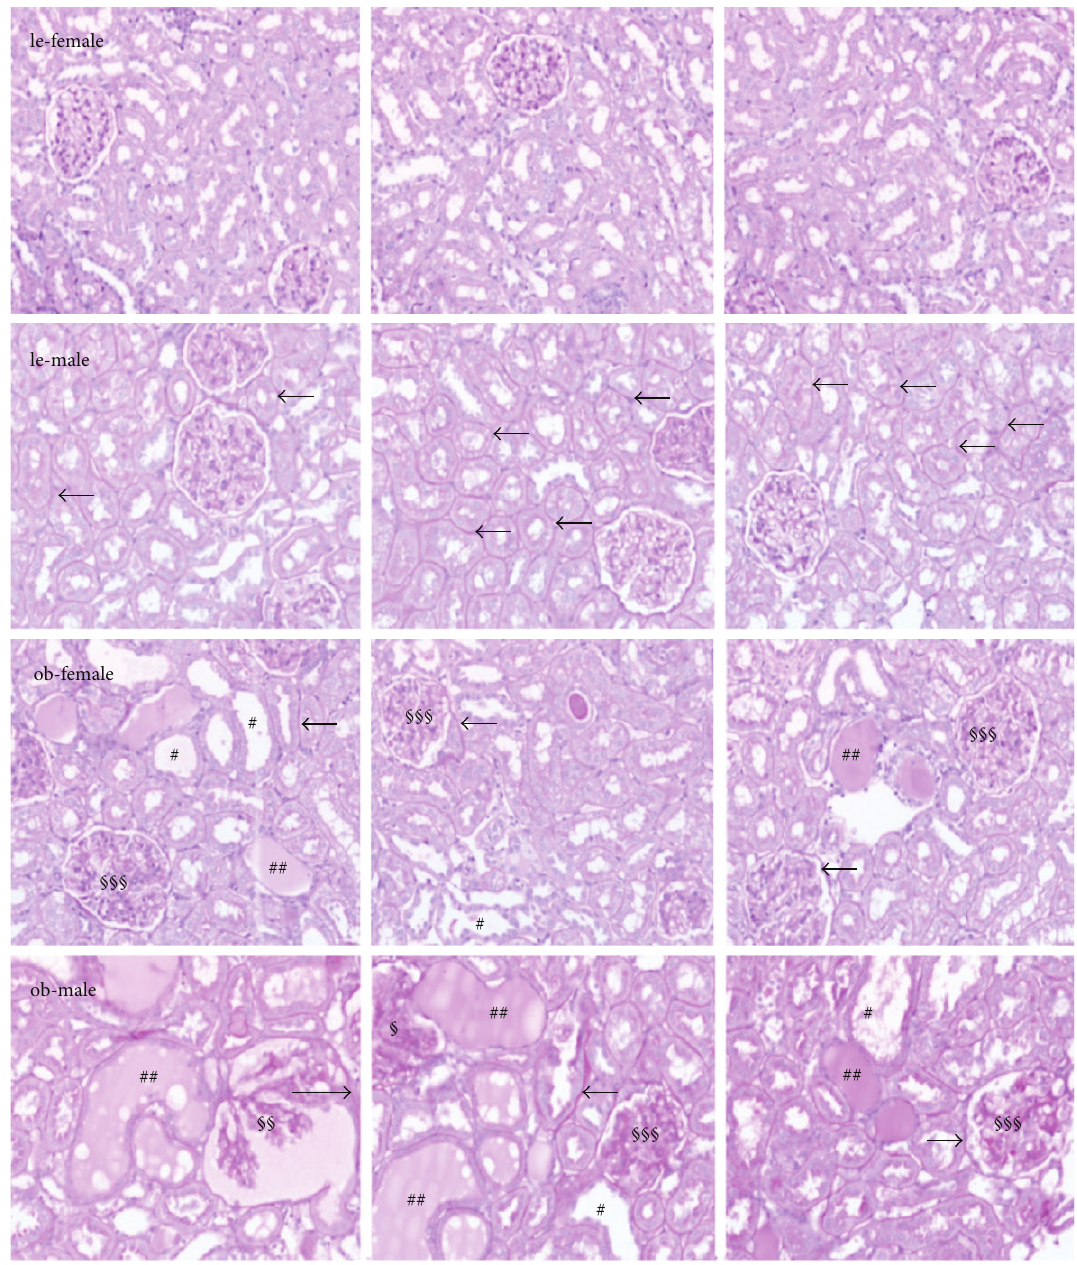
Figure 1: PAS staining in renal cortical slices. Renal sections of lean (le) and obese (ob) ZSF1 rats were stained with PAS and structural changes were analyzed. Examples for histological changes in renal tissue are marked as follows: #, tubular atrophy and dilatation; ##, hyaline protein casts in tubular lumen; §, pressure-induced deformation of glomerulus; §§, dilatation of Bowman’s capsule and protein cast in Bowman’s space; §§§, glomerulosclerosis. The arrows mark the thickening of tubular and glomerular basement membranes. Magnification: 200x. Representative images from three different rats under each condition are